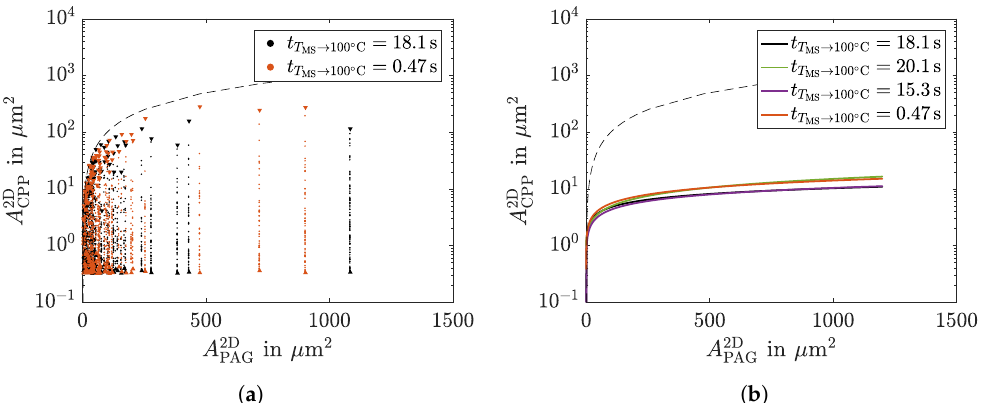
Figure 8. Packet cross-section area depending on the prior austenite grain (PAG) cross-section area: ( a ) measured data, ( b ) representation of measured data with fitted curves.